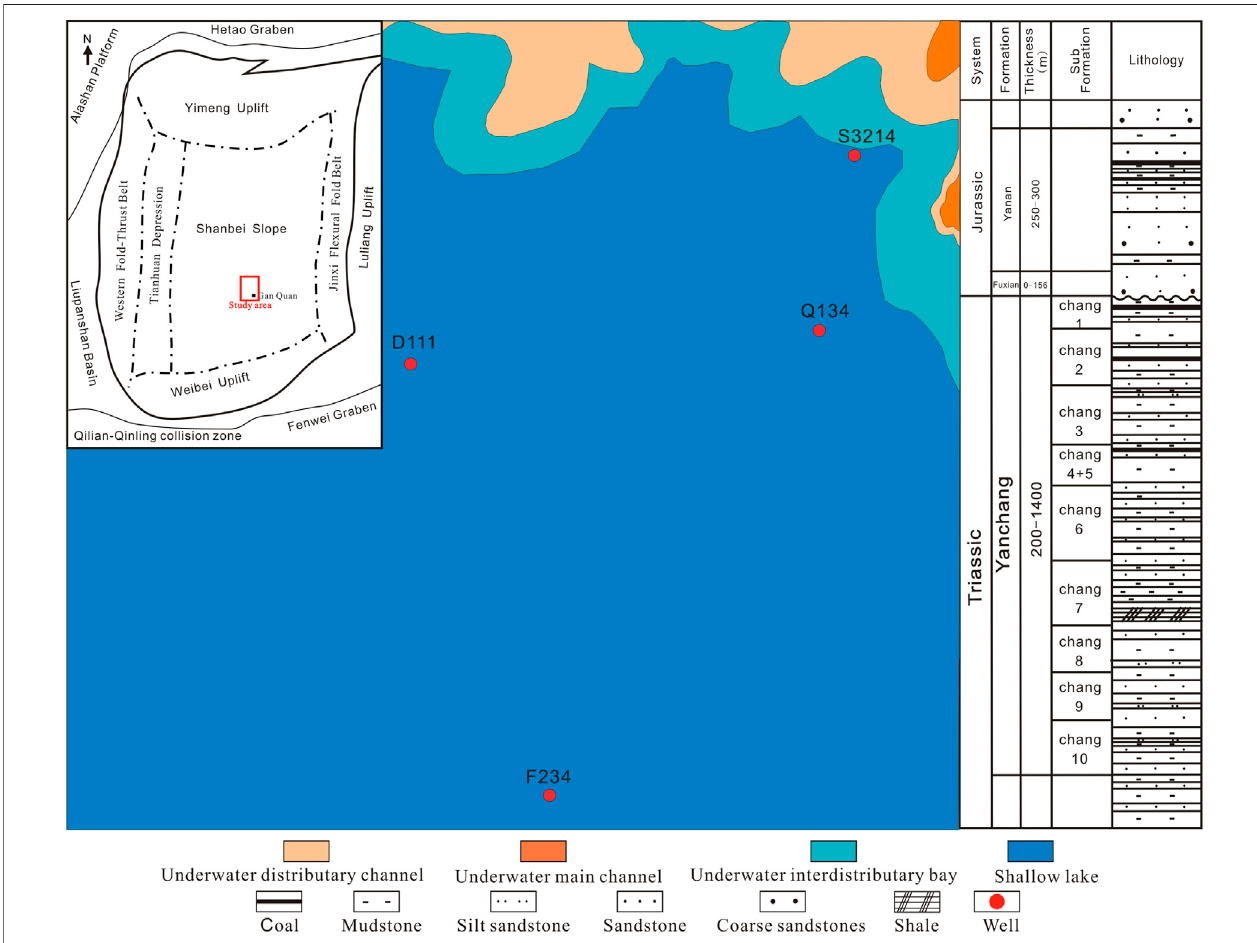
FIGURE 1 | Map showing the location and paleogeography of the study area. A stratigraphic and lithological column of Triassic Chang-7 shale as part of the Yanchang Formation is also shown on the right.